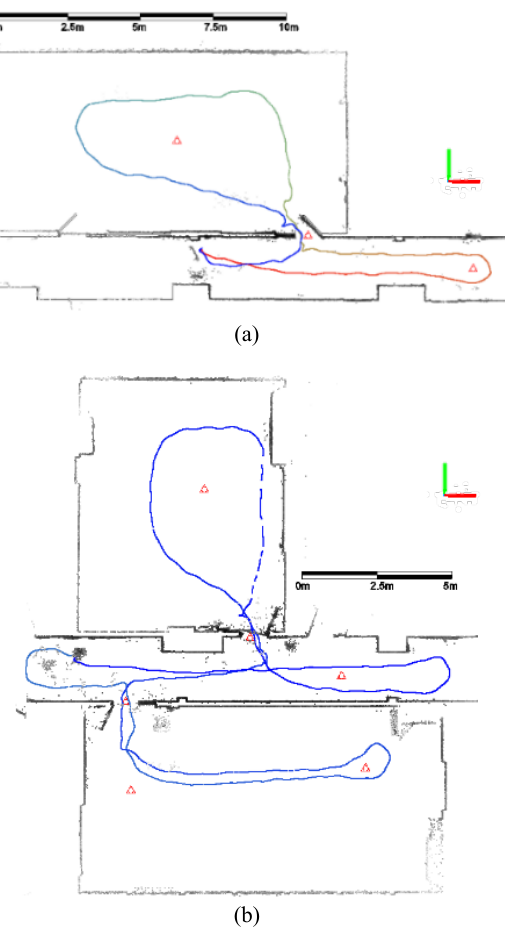
Figure 2. Distribution of SLS stations (red triangles) superimposed with the point cloud of the MMS acquisition for two loops, in a top view. (a) Loop 1, (b) Loop 2.